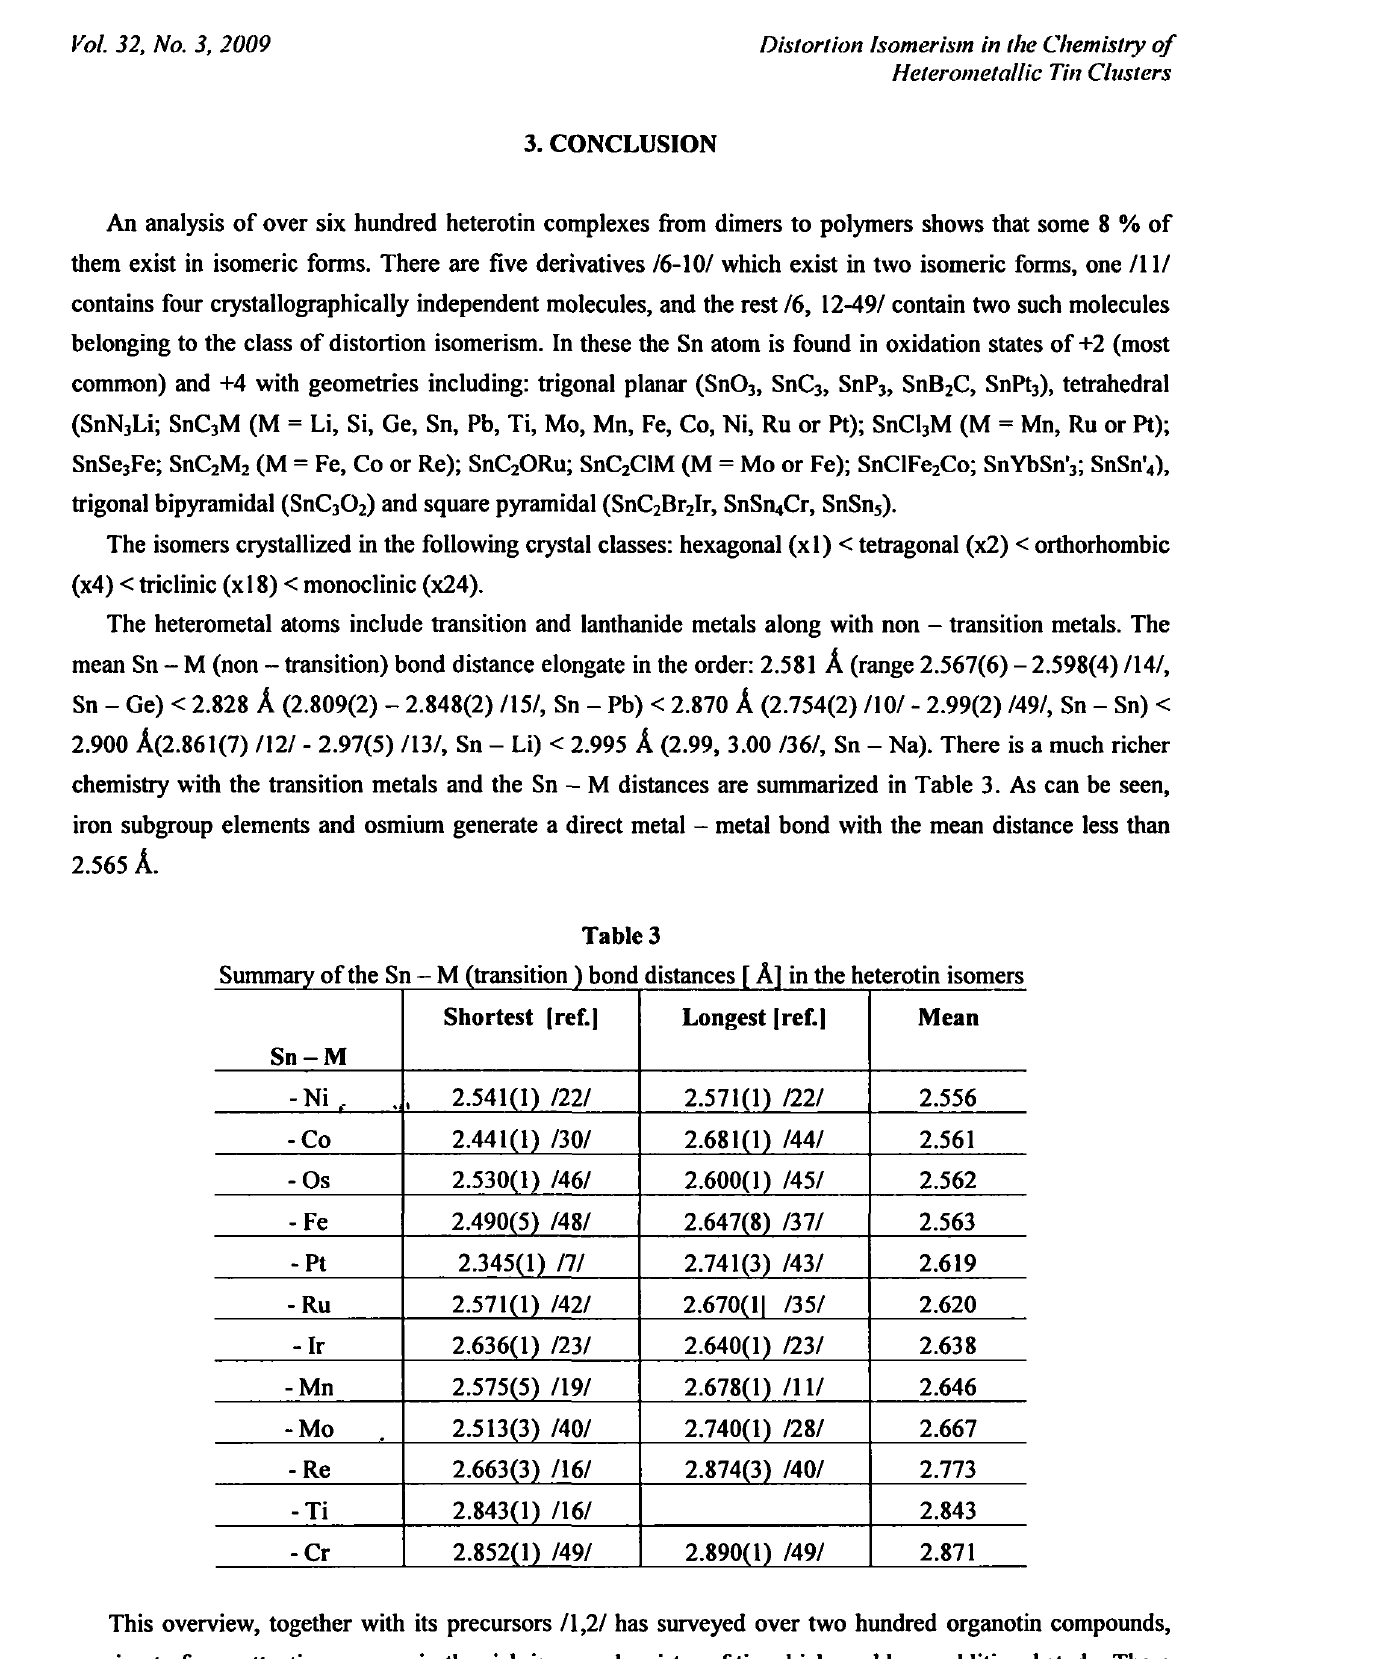
Summary of the Sn - M (transition ) bond distances [ A] in the heterotin